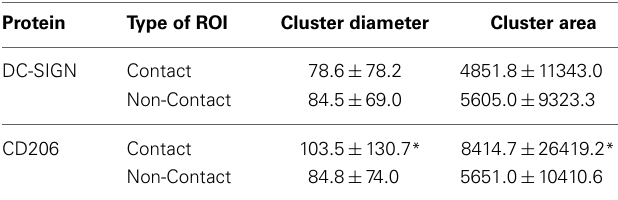
Table 2 | DBSCAN statistical analysis of clustering and local density in fungal contact regions on dendritic